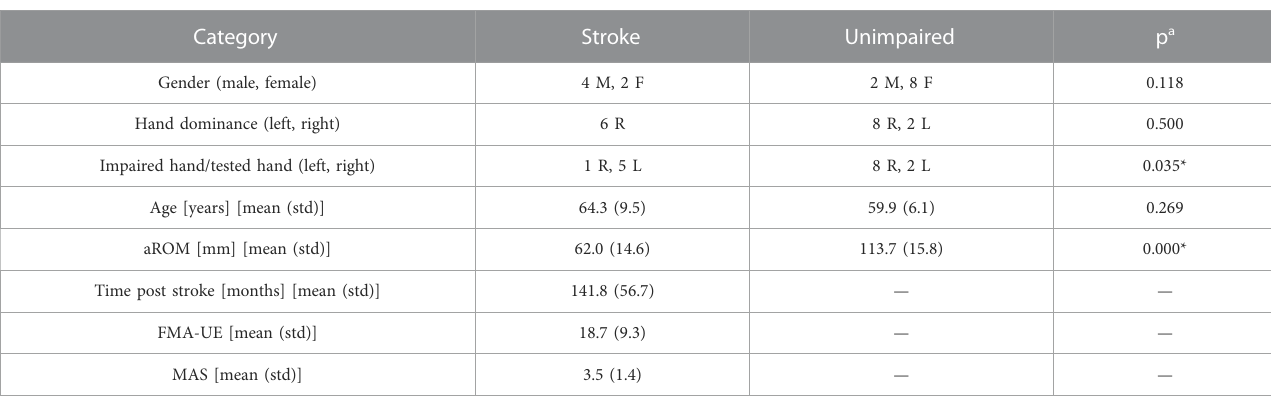
TABLE 1 Baseline characteristics.